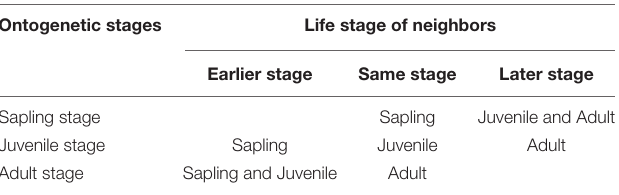
TABLE 2 | Division of different life stages of neighbors across ontogenetic stages of focal trees. All focal trees and neighbors were classified as saplings, juveniles or